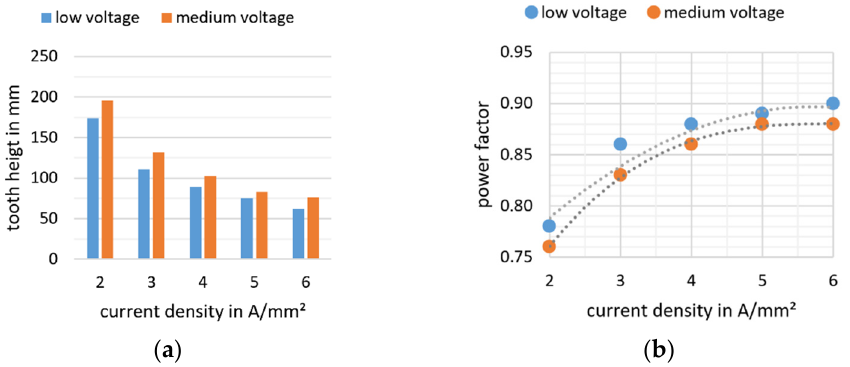
Figure 10. ( a ) Tooth height depending to the current density; ( b ) Behavior of the power factor de- pending to the current